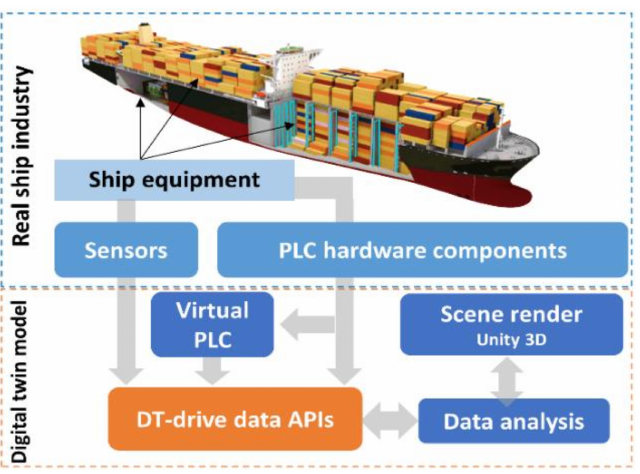
Figure 1. Specific process of data communication between the real scene and DT